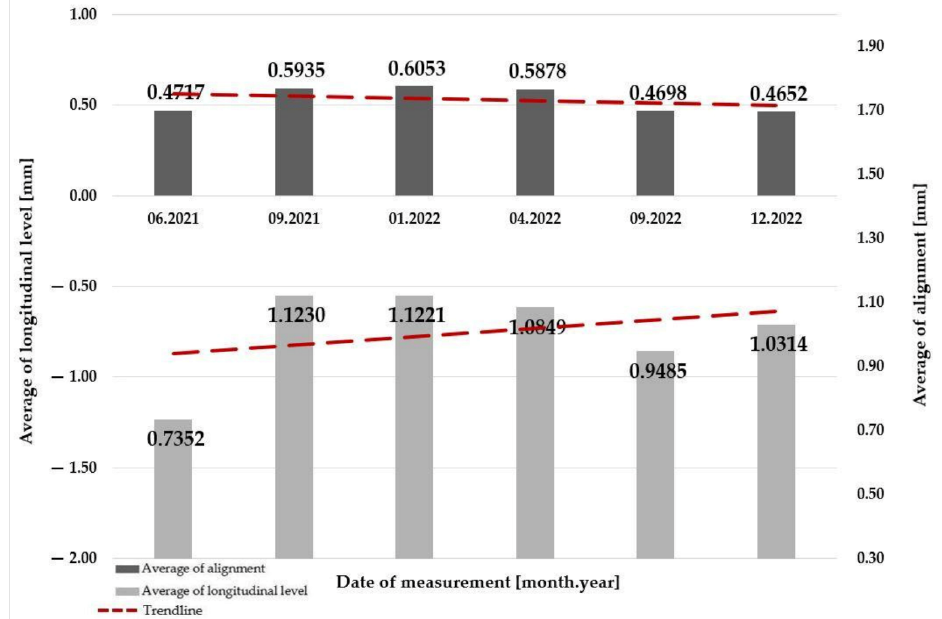
Figure 13. The change of average values of longitudinal level and alignment in Section